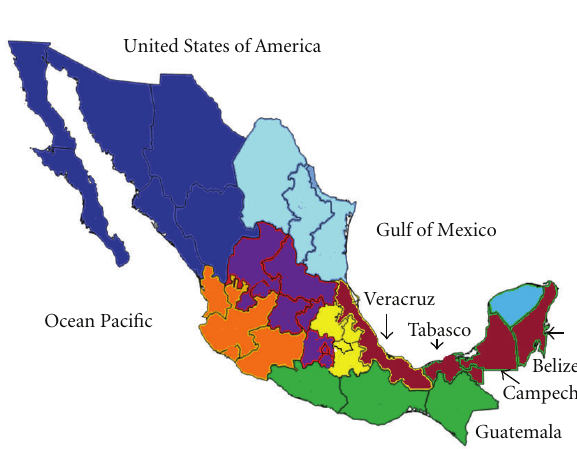
Figure 1: Map of Mexico, showing the endemic regions studied in this work, Veracruz, Tabasco, and Campeche